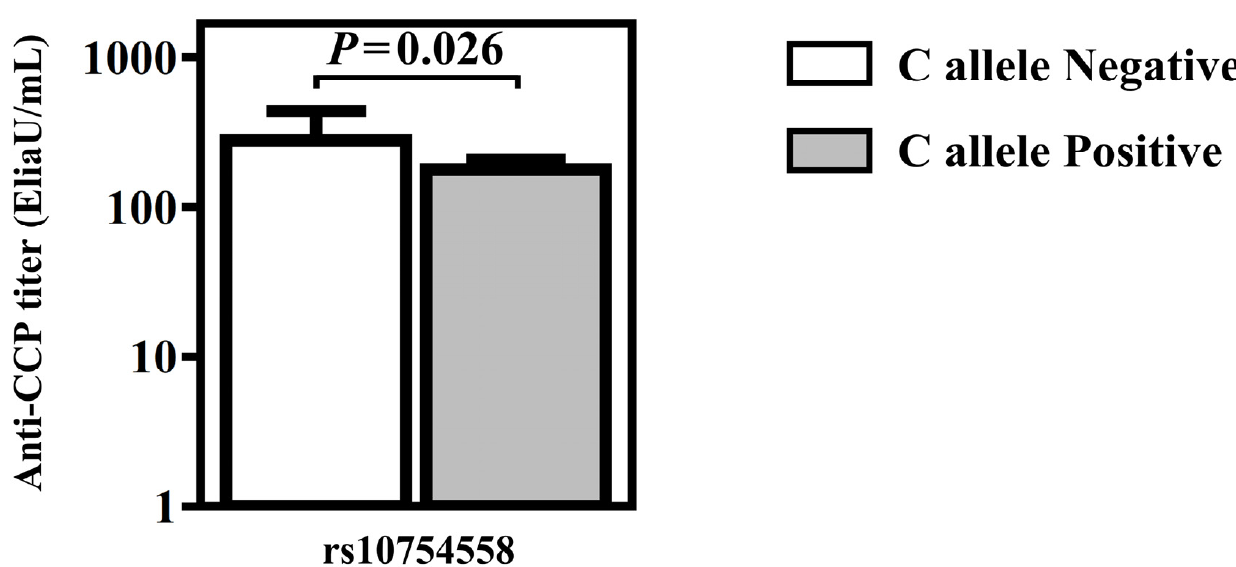
Figure 1. Associations of rs12079994 G/A polymorphisms with titer of rheumatoid factor.